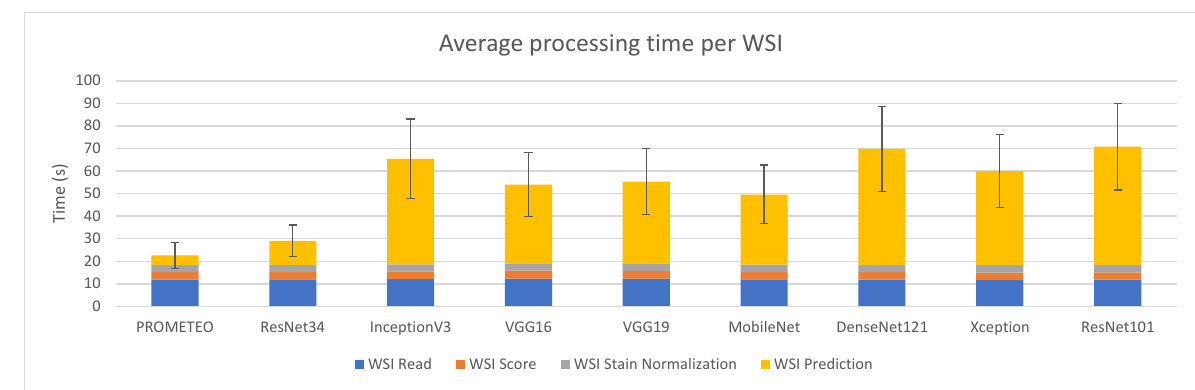
Figure 6. Average WSI processing time (in seconds) and standard deviation for each of the CNN architectures using computer M (see Table A1).